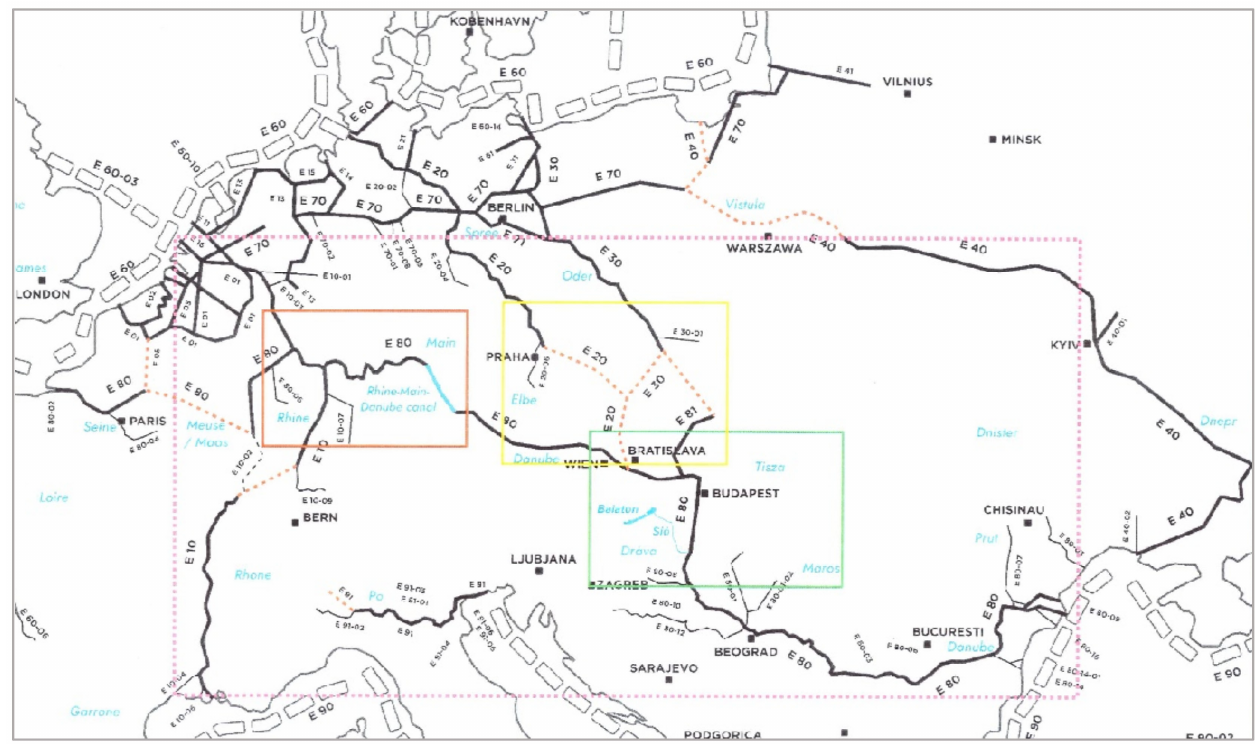
Figure 2. Master figure showing the locations of key areas mentioned in this study. Legend: The Rhine–Main–Danube Canal; The hydrographic catchment areas of the Rhine, Rh ô ne, Po, and Danube rivers draining the Alps; The concept of the Danube–Oder–Elbe Canal, in- cluding the V á h River, resulting in a substantial NE extension of the Rhein-Main-Danube corridor; Map of Hungary with Lake Balaton and the Si ó canal linking the lake to the river Danube. Source: redrawn from Figure